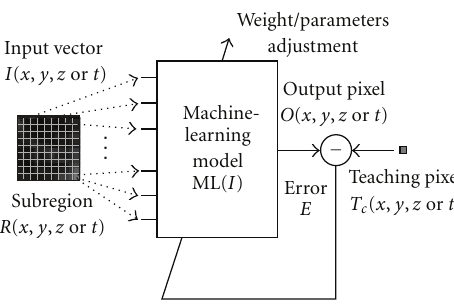
Figure 2: Training of an MTANN (a class of PML). An input vector is entered as input to the ML model. An error is calculated by subtracting of a teaching pixel from an output pixel. The parameters such as weights between layers in an ANN model are adjusted so that the error becomes